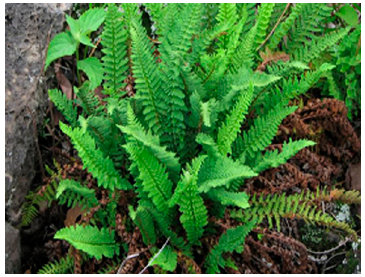
Figure 1. Dryopteris fragrans .